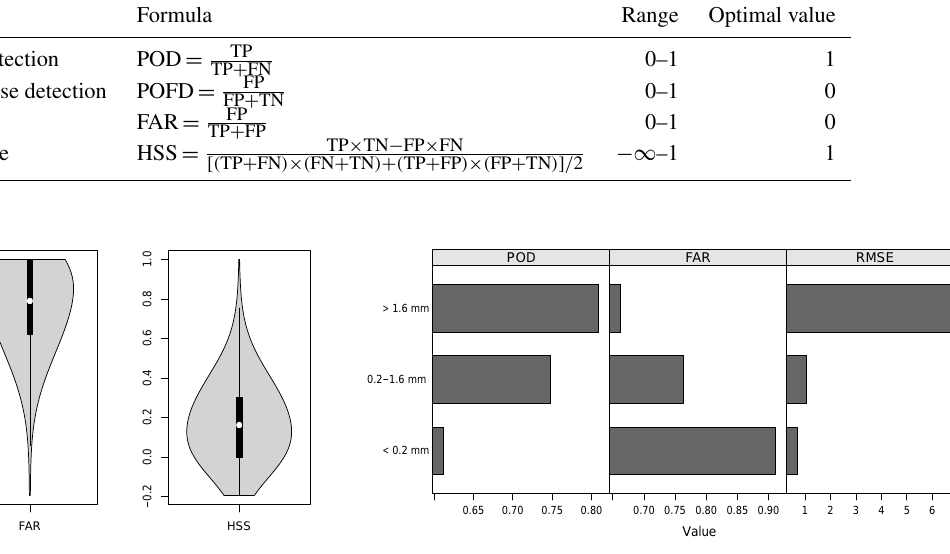
Figure 3. Validation of estimated rainfall areas for 2013 on an hourly basis. Each of the data points is the average performance of 1h. The data are visualised as “vioplot” which entails that a box plot is complemented by the kernel density of the data shown as grey areas at the sides of the box plot.